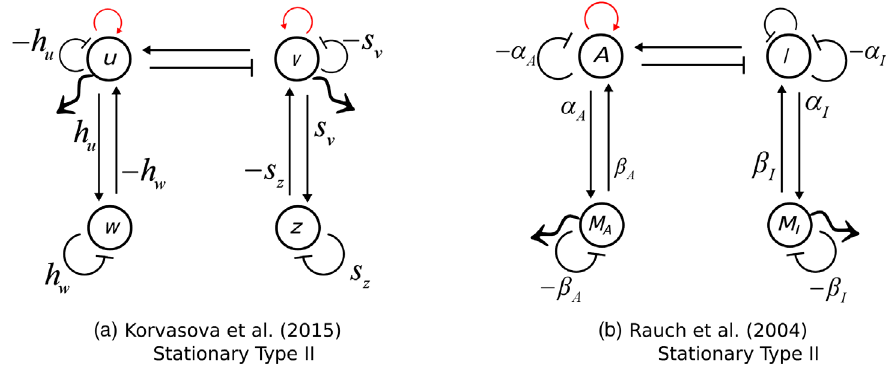
FIG. 12. (a) Network composed of two diffusible self-activators that bind to two immobile substrates [19]. (b) A model of biological patterning based on two morphogens that diffuse in the extracellular space and activate the production of gene products A and I that are confined inside cells